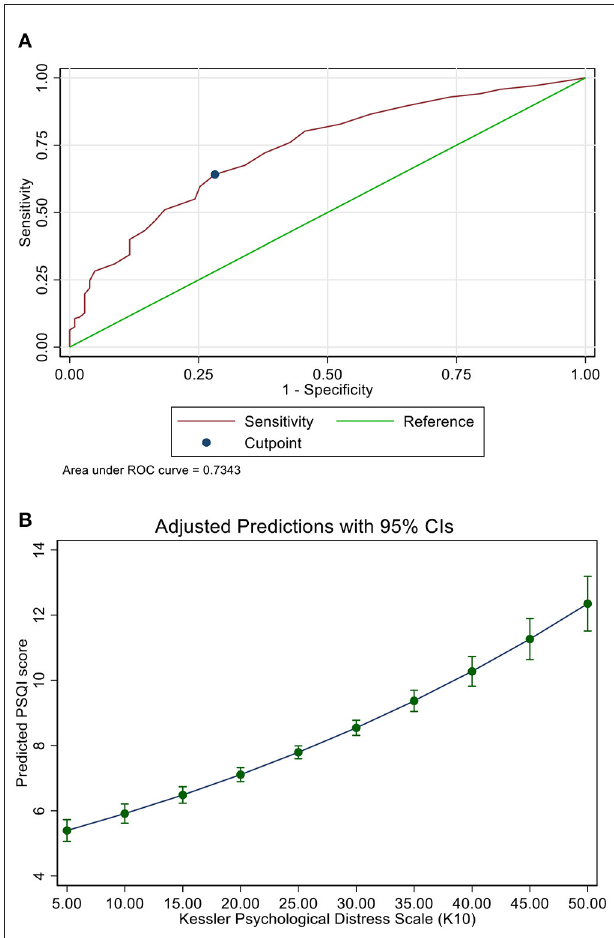
FIGURE 3 | (A) The receiver operator curve (ROC) for the cut-off point of K-10 score predicting poor sleep. (B) The predicted PSQI score according to the K-10